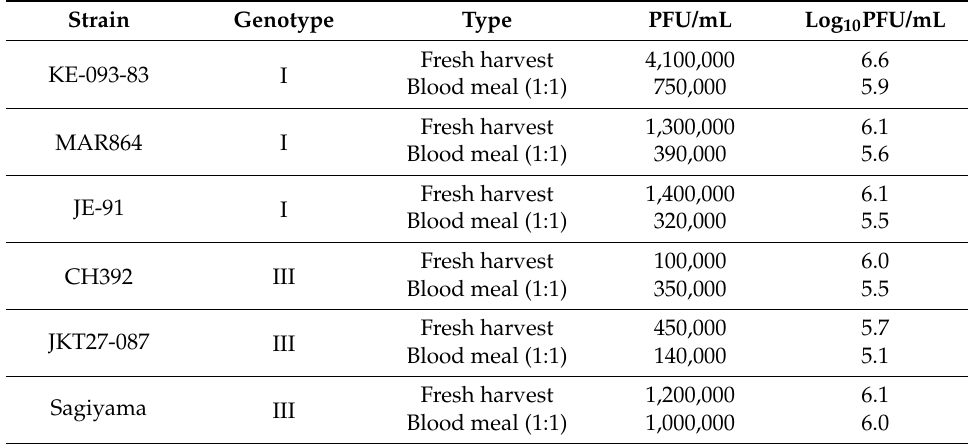
Table 3. Titration of the freshly harvested and the blood meal Japanese encephalitis virus strains. Strain